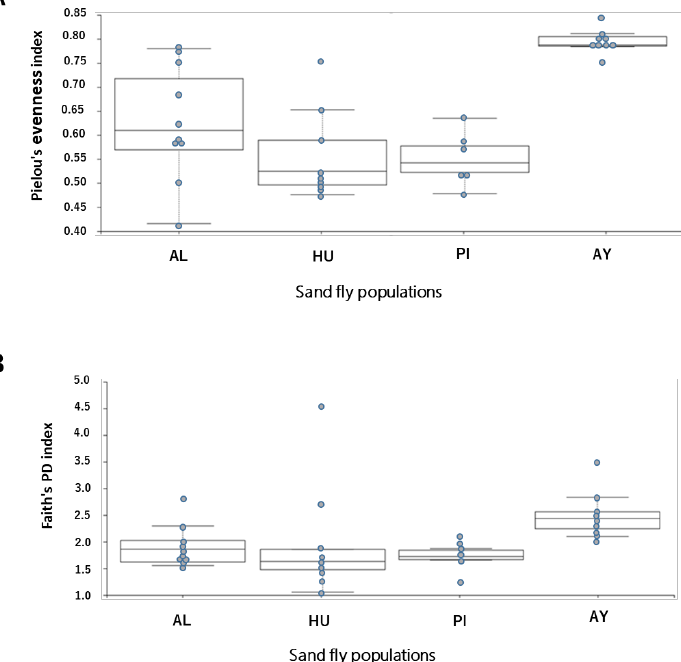
Figure 4. Box plots of the alpha diversity measure using Pielou ’ s evenness index ( A ) and Faith’s phylogenetic diversity index ( B ) in Lutzomyia ayacuchensis populations. Ecuador (AL, Alausi; HU, Huigra); northern Peru (PI, Piura); southern Peru (AY, Ayacucho).